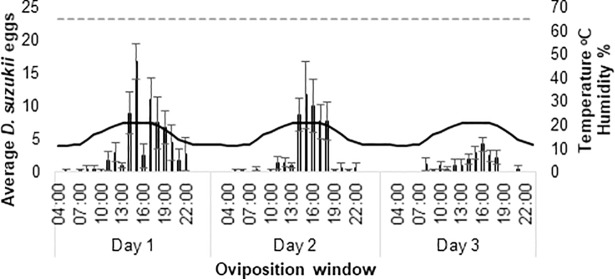
Average oviposition of laboratory strains under recreated June conditions within the laboratory.Average reproductive oviposition (+SE) collected in 2 hour ‘oviposition windows’ over three days. Average temperature (black solid line) and relative humidity (RH) (dashed grey line at x 0.5) cycled through-out. Note that relative humidity was kept constant at 65% in laboratory assays. Light is indicated by the colour of average D. suzukii bars. Black = darkness, grey = half-light and white = light.